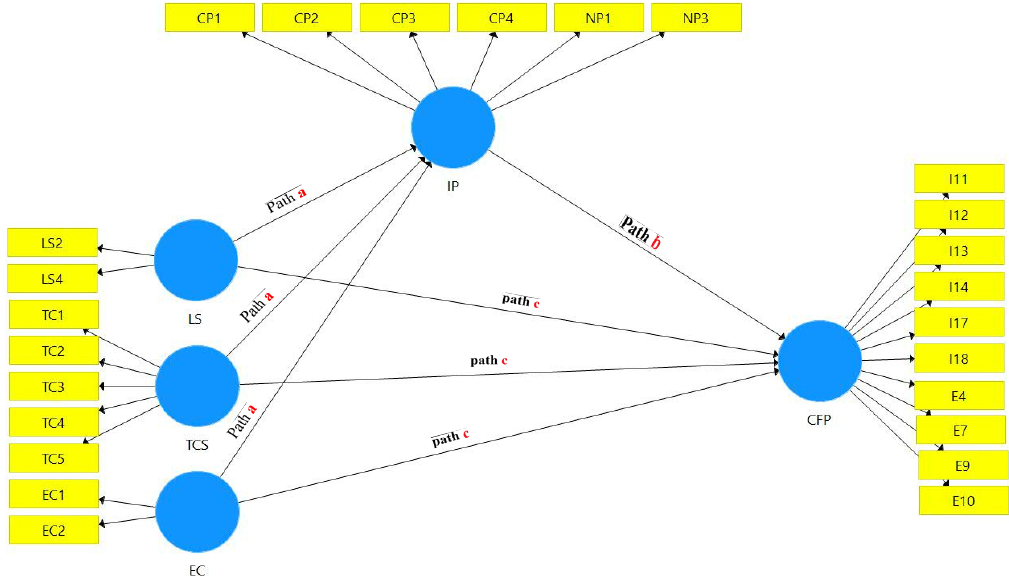
Figure 7. Mediation path